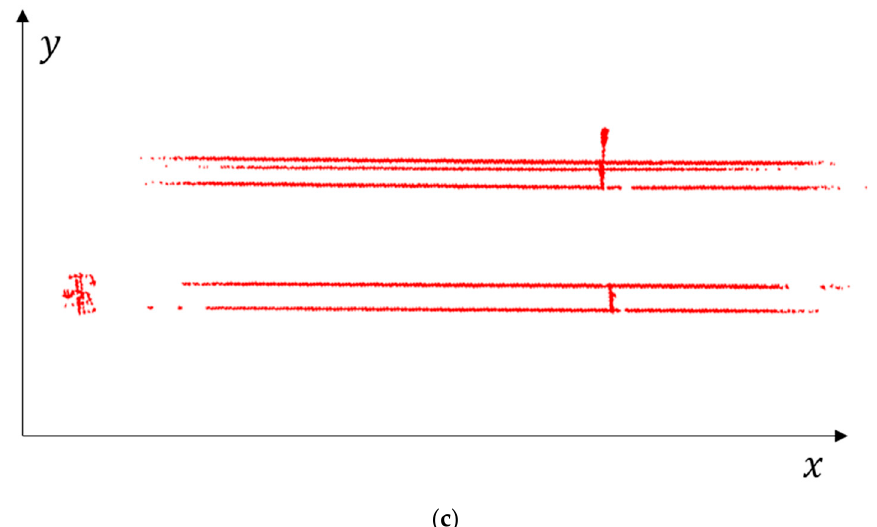
Figure 5. Data preprocessing. ( a ) Result of ground filtering and height filtering. Red points indicate the off–ground part, gray points are the ground part that has been removed. ( b ) Calculation of θ . ( c ) Rotated data (top